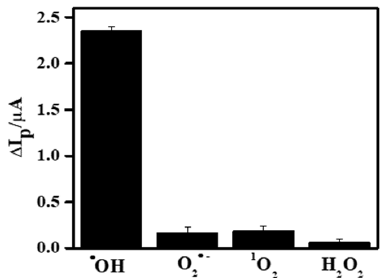
• 3 N 4 /chitosan/GCE in PBS with